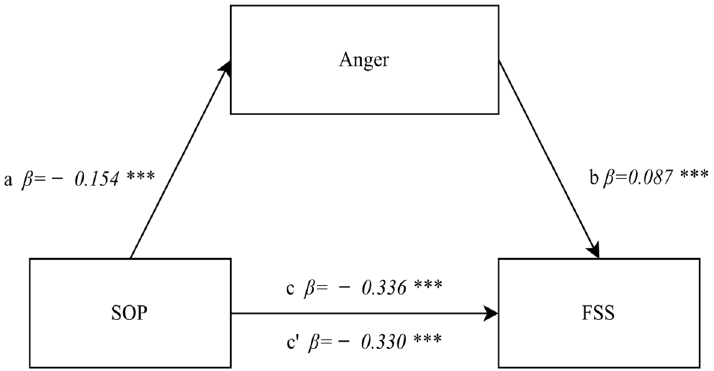
Figure 4. A relationship diagram of the model testing the mediatory effect of anger control on the relationship between positive orientation and the degree of tiredness/fatigue. Statistically significant: *** p < 0.001. Explanation: SOP—positive orientation, FSS—fatigue severity scale.